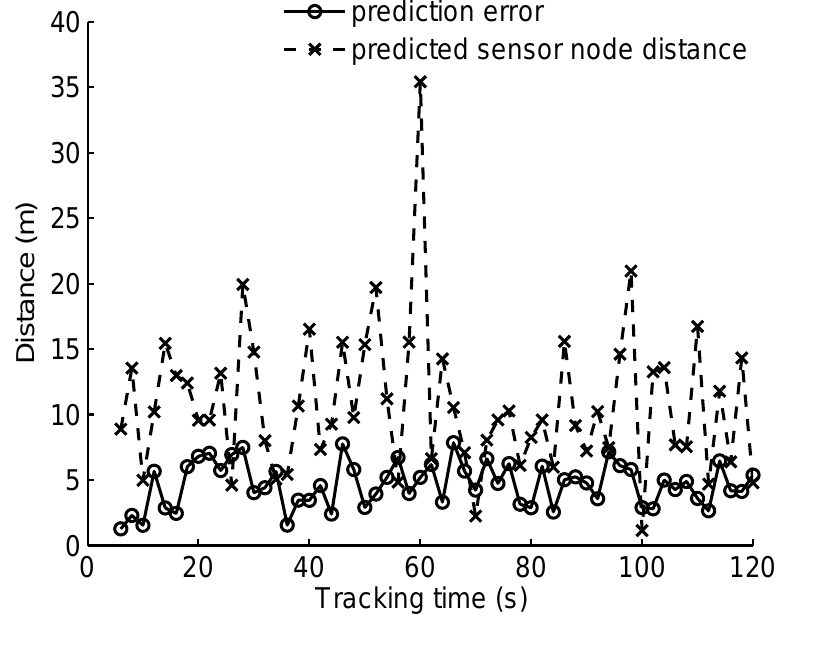
Figure 7 . Prediction error and distance between predicted location and the predicted sensor node. prediction error predicted sensor node